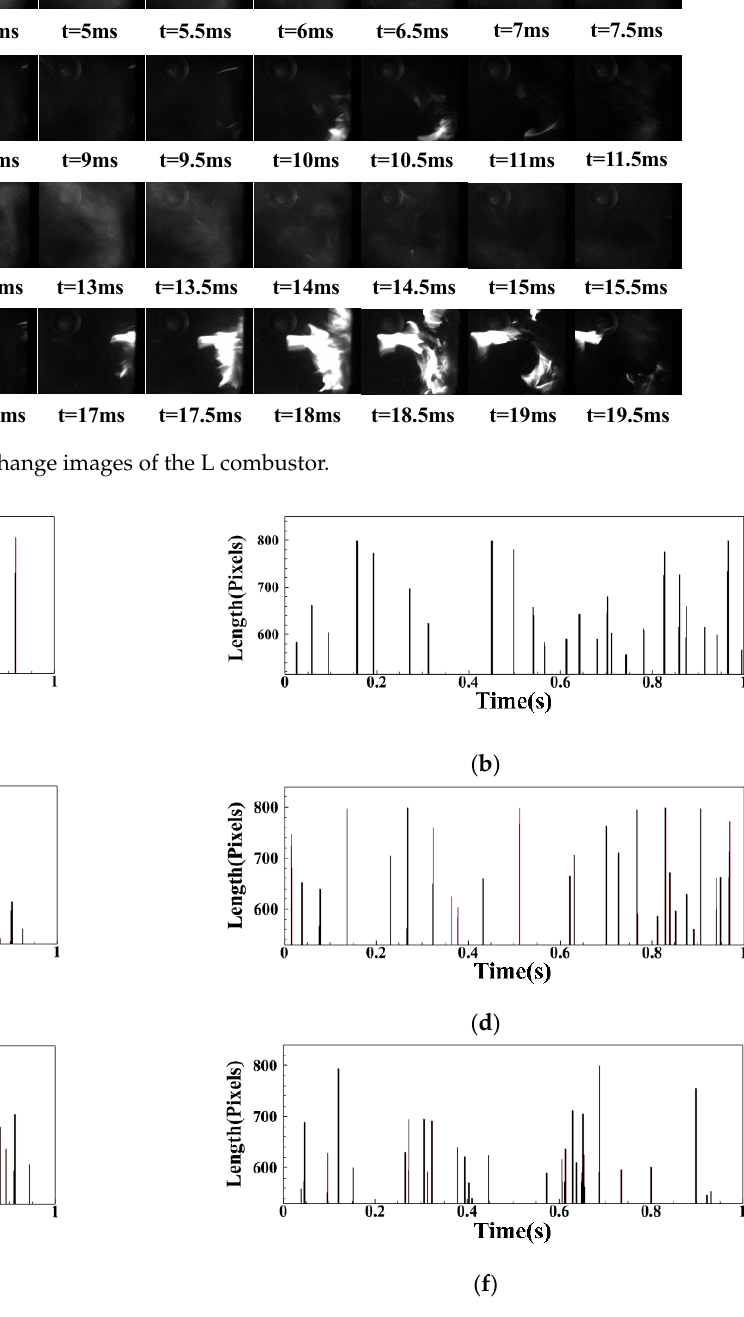
Figure 26. Statistics of flame shedding under operating conditions of group LA: ( a ) LA01; ( b ) LA02; ( c ) LA03; ( d ) LA04; ( e ) LA05; ( f ) LA06.